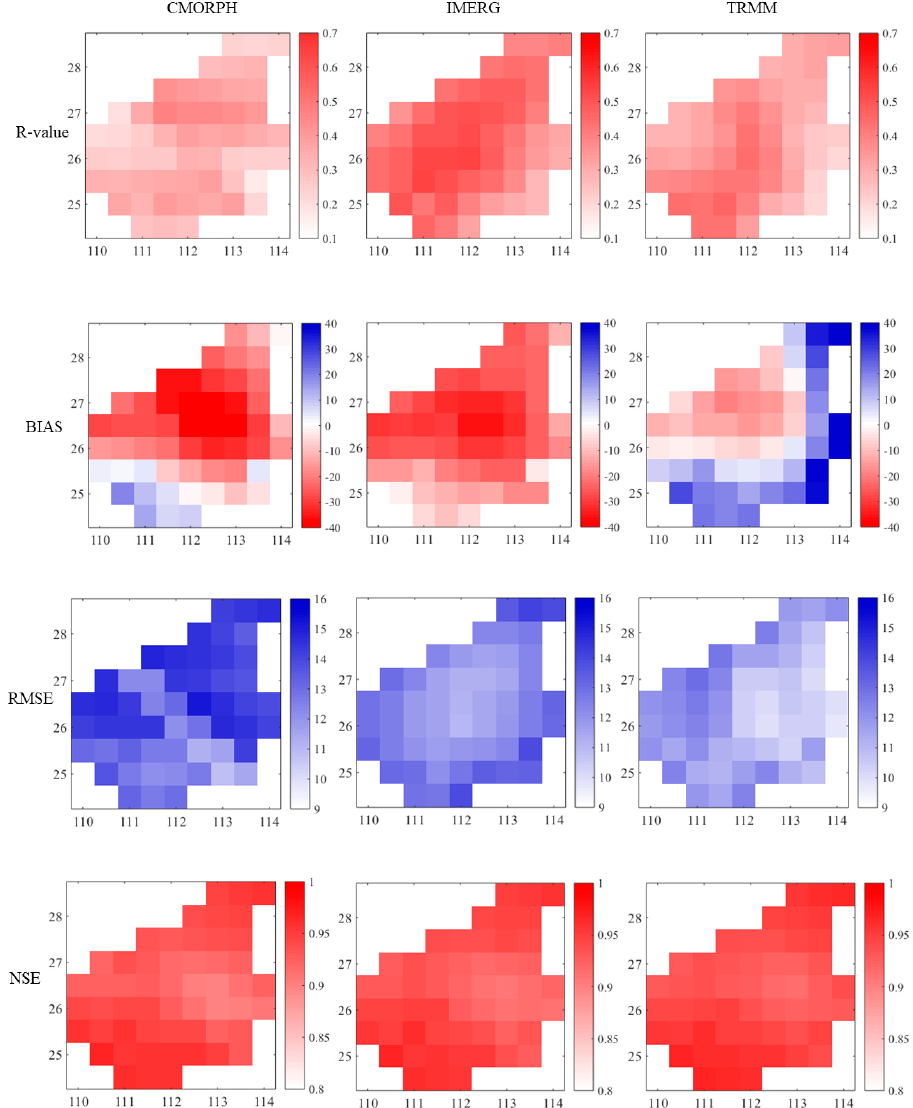
Figure 6. Spatial distribution of the R-value, relative bias (BIAS), root mean square error (RMSE), and Nash–Sutcliffe efficiency (NSE) values based on an evaluation of daily 0.5° × 0.5° grid-based precipitation data.